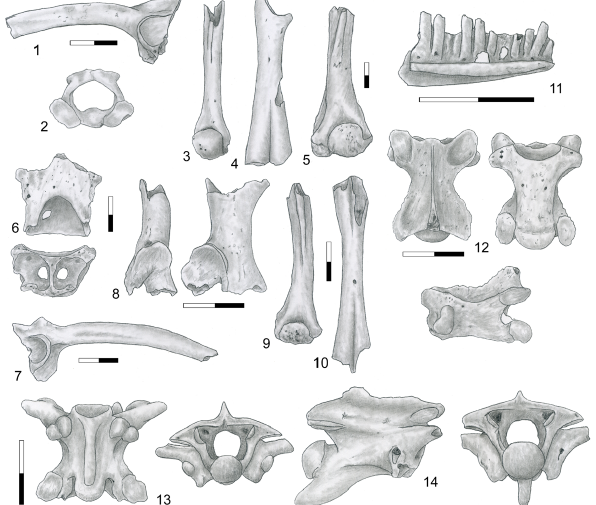
Fig. 4. Some amphibians and squamates from Canyars. 1–4, Pelodytes punctatus . 1: left ilium, lateral view; 2: atlas, anterior view; 3: right humerus of female, ventral view; 4: radioulna, lateral view; 5, Bubo cf. bufo , left humerus of female, ventral view; 6–10, Bufo calamita . 6: sphenethmoid, dorsal and anterior views; 7: right ilium, lateral view; 8: right scapula, posterior and dorsal views; 9: right humerus of female, ventral view; 10: tibiofibula, dorsal view; 11, Lacertidae indet., left dentary, medial view; 12, Anguis fragilis , trunk vertebra, dorsal, ventral and left lateral views; 13, Coronella cf. austriaca , trunk vertebra, ventral and posterior views; 14, Vipera sp., trunk vertebra, right lateral and posterior views. All scales equal 2mm.